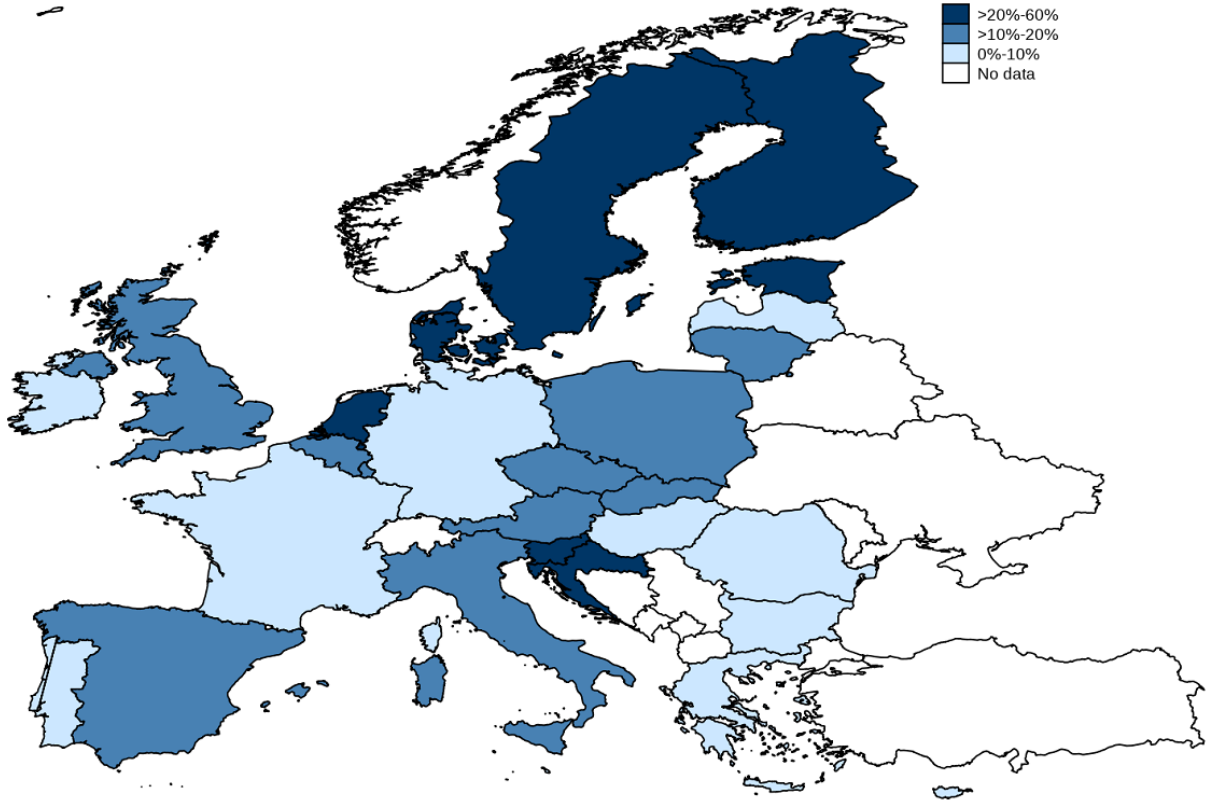
Figure 1. Geographical distribution of elderly people using internet-based health care